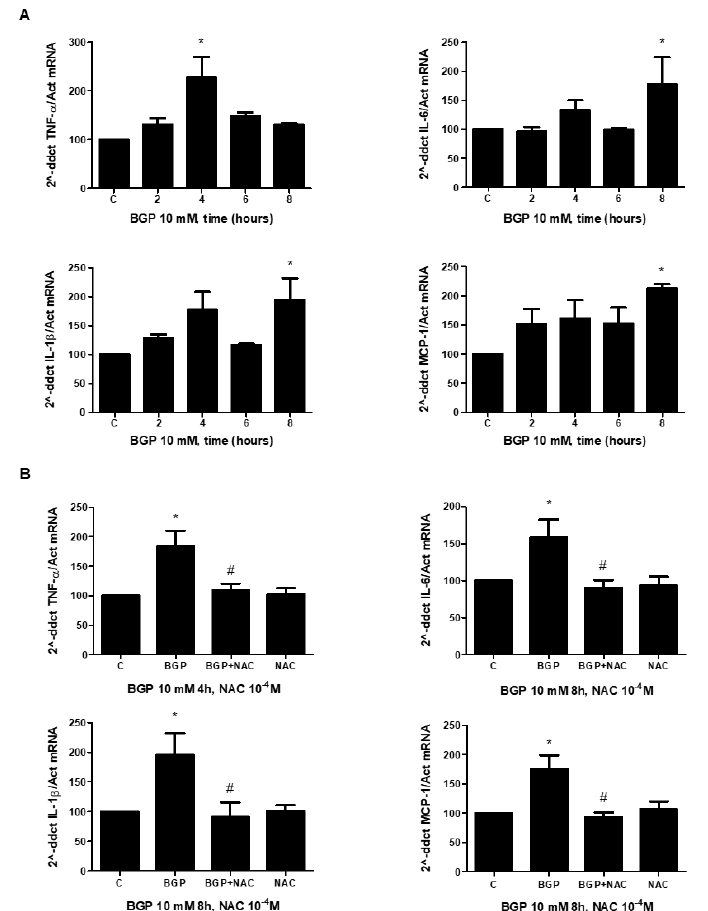
Figure 7. BGP-induced inflammation depends on oxidative stress in human endothelial cells. A human endothelial cell line (EA.hy926) was treated with 10 mM BGP at different times ( A ). Some cells were incubated in the presence of 100 µM N-acetylcysteine (NAC) and then BGP was added at indicated times ( B ). ( A , B ) The expressions of several cytokines, TNF-α, IL-6, IL-1ß and MCP-1, were analyzed by real-time PCR in endothelial cells treated with BGP at different times ( A ) or in cells treated with BGP in the presence or the absence of NAC at indicated times ( B ). Values are the mean ± SEM of 6 ( A ) or 4 ( B ) independent experiments, * p < 0.05 vs. control cells ( C ) and # p < 0.05 vs. BGP alone.